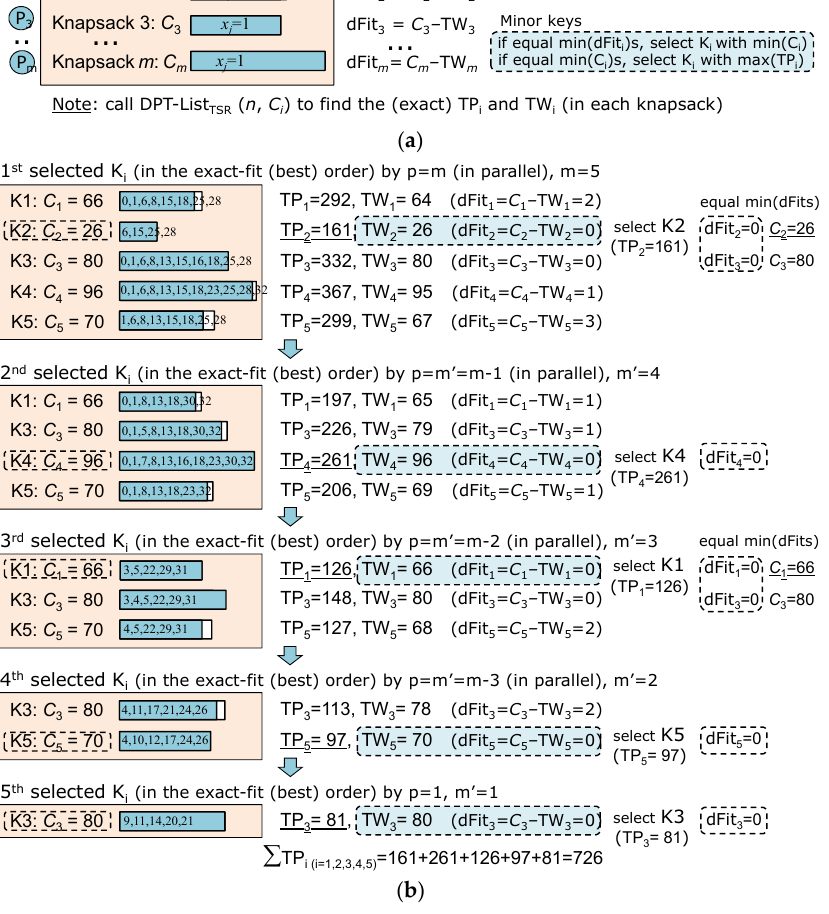
Figure 11. ( a ) The exact-fit policy for the best knapsack order and ( b ) an example of n = 33, m = 5, C = (66,26,80,96,70) to find the best order (2,4,1,5,3) in m ( m + 1)/2 = 15 steps and the optimal result (726). Algorithm 10: multi-DPT-List TSR (the exact-fit (best) knapsack order).